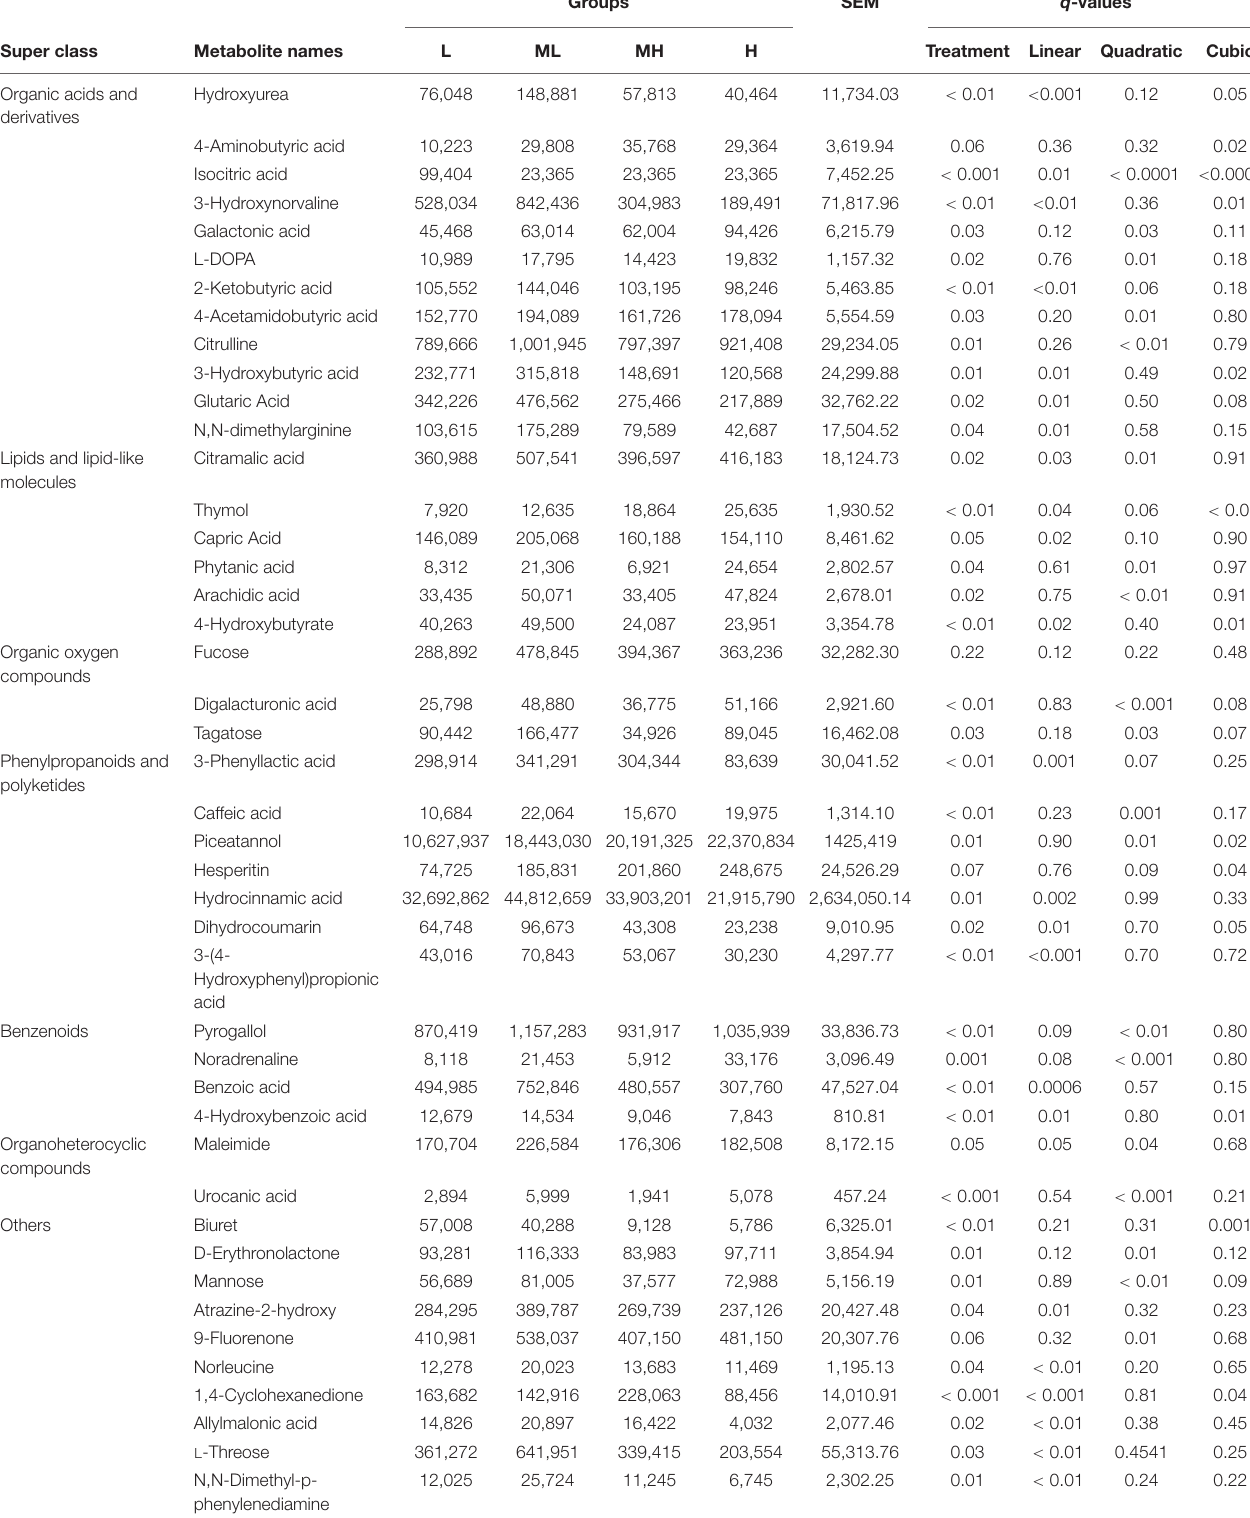
TABLE 2 | Comparisons of ruminal metabolites that significantly changed with yak fed diets containing different protein level ratios. Groups SEM q